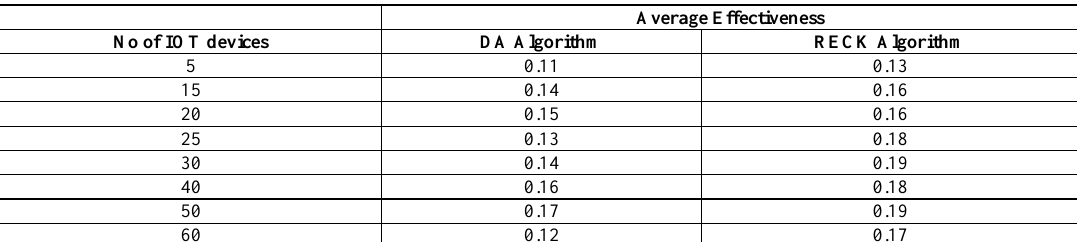
Table 5. Highlights the data of DA and RECK algorithm in the context of average